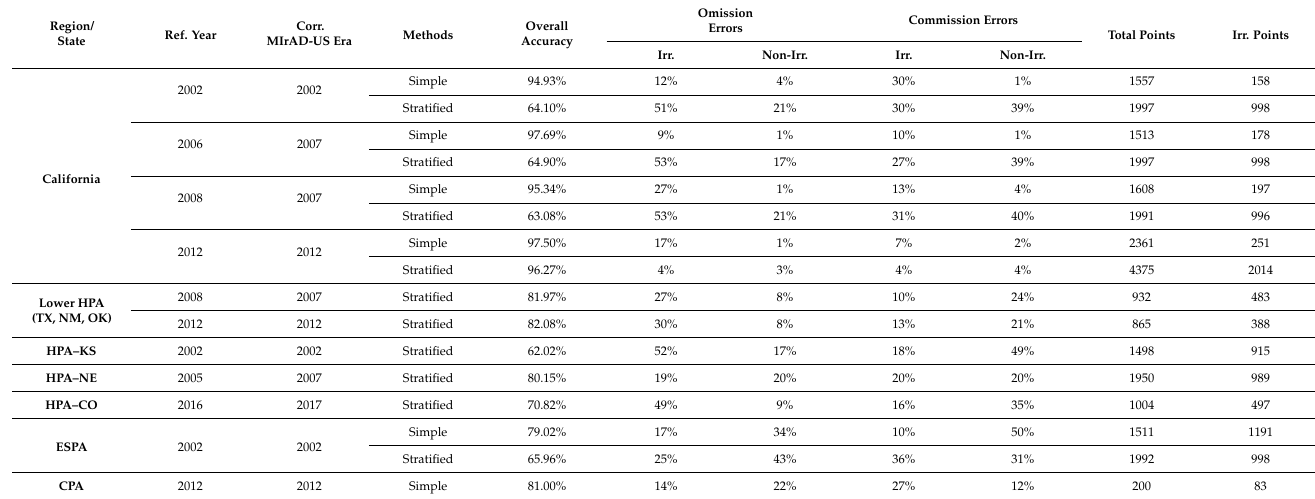
Table 4. Error matrix summary of irrigated and non-irrigated category between MIrAD-US and reference data. Region/